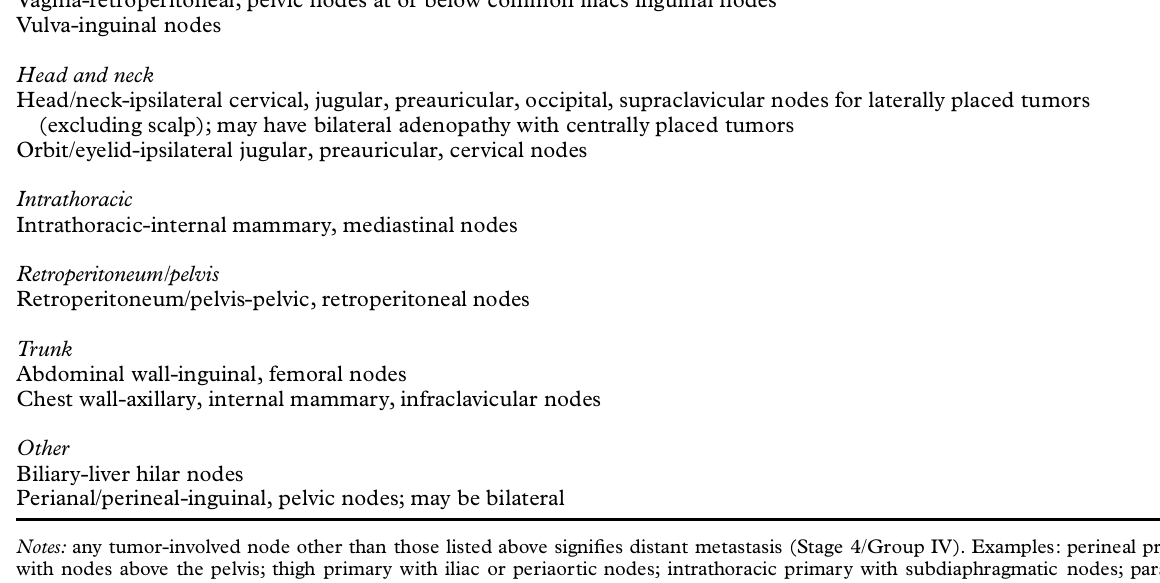
Table 2. Regional nodal basins for